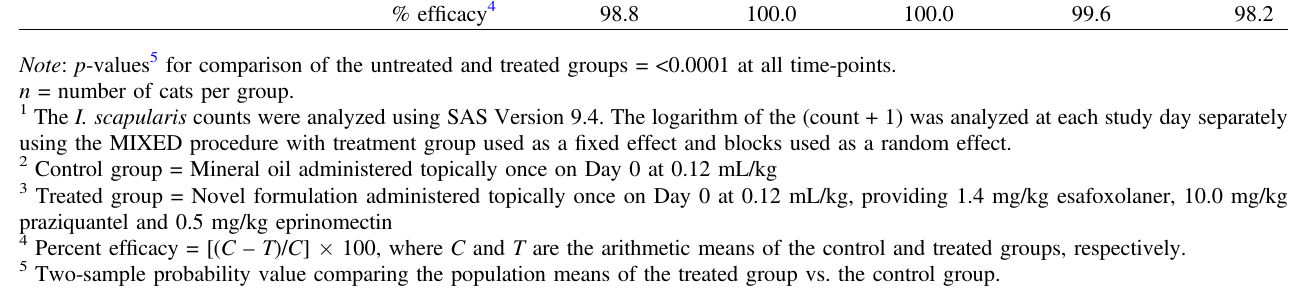
Table 4. Ixodes scapularis studies: mean live tick counts per group and ef fi cacy results Study n Arithmetic means (AM) of live ticks and % efficacy 1 on indicated days